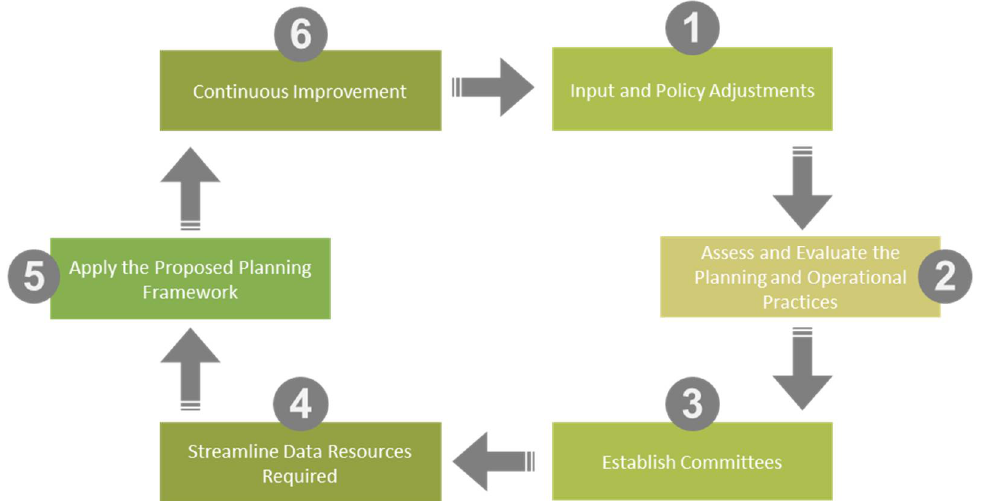
Figure 6. Transitional roadmap to an enhanced capacity planning practice.